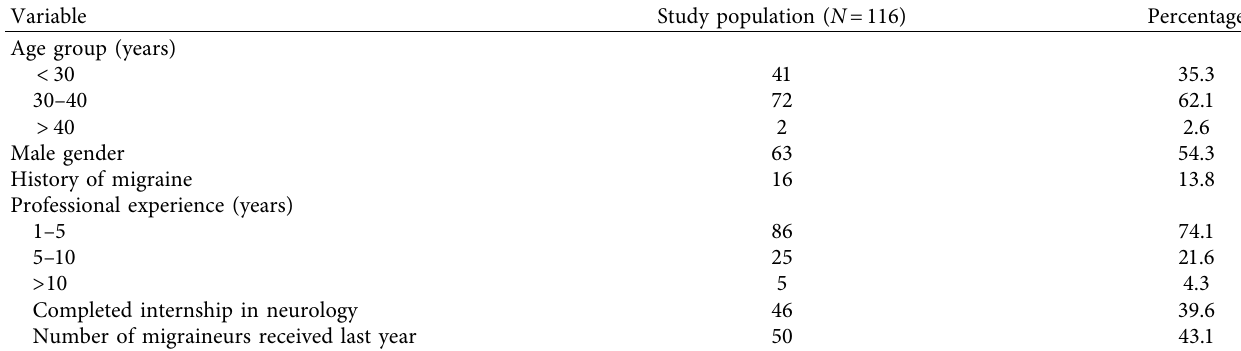
Table 1: Sociodemographic and professional characteristics of GPs ( N � 116).